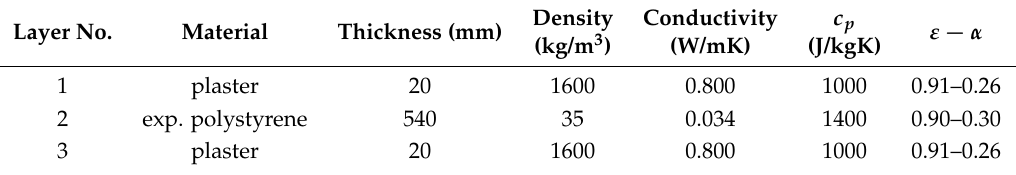
Table A7. Case G: ultralight wall, “PL4” (Layer 1 is outdoors). Thickness: 580 mm. Layer